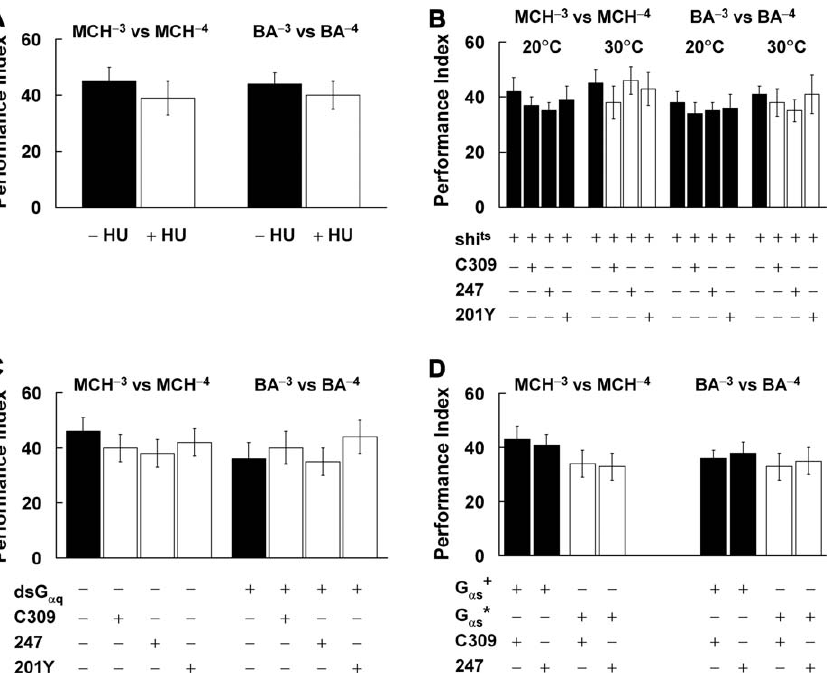
Figure 1. Spontaneous Odor Intensity Discrimination Does Not Require the Normal Function of MB In this and the following figures, all control groups are shown in black bars, and the experimental groups in white bars, or blue when statistically significantly different from the control ( p , 0.05), and all experiments were done in a balanced and experimenter-blind manner. Spontaneous intensity discrimination between different concentrations of MCH (left panels) or BA (right panels) was not affected (A) by MB ablation ( þ HU), (B) by transient block (30 8 C) of temperature-sensitive (20 8 C, permissive; 30 8 C, restrictive) shibire -dependent synaptic transmission using three different MB PGAL4 drivers (C309, 247, and 201Y), (C) by RNAi-mediated disruption of G a q using the same MB PGAL4 drivers, or (D) by overexpression of constitutively active G a s * (with G a s þ as controls) using two MB PGAL4 drivers (C309 and 247). n ¼ 4 PIs for all